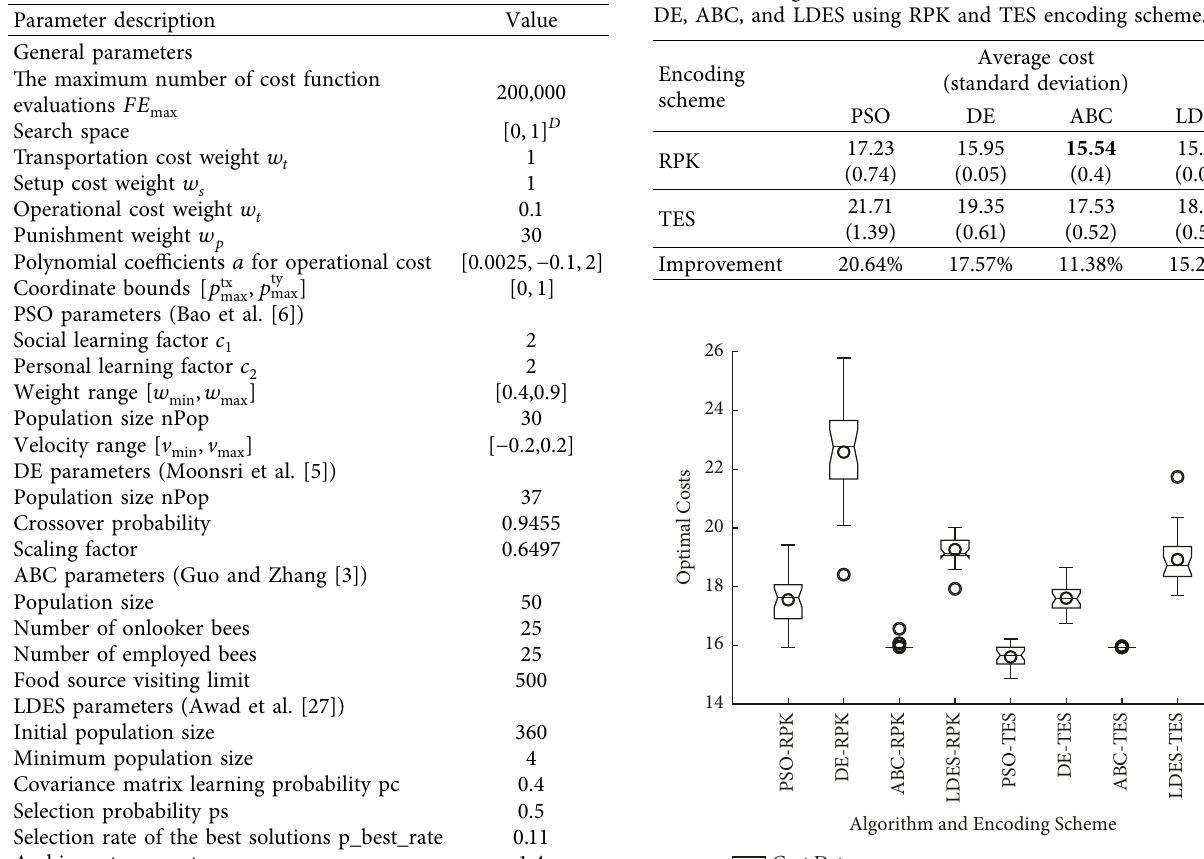
Figure 4: The regional grid map of Zhenjiang, China, with an operational cost for each lattice. Table 2: Parameter settings for PSO, DE, ABC, and LDES algorithms.